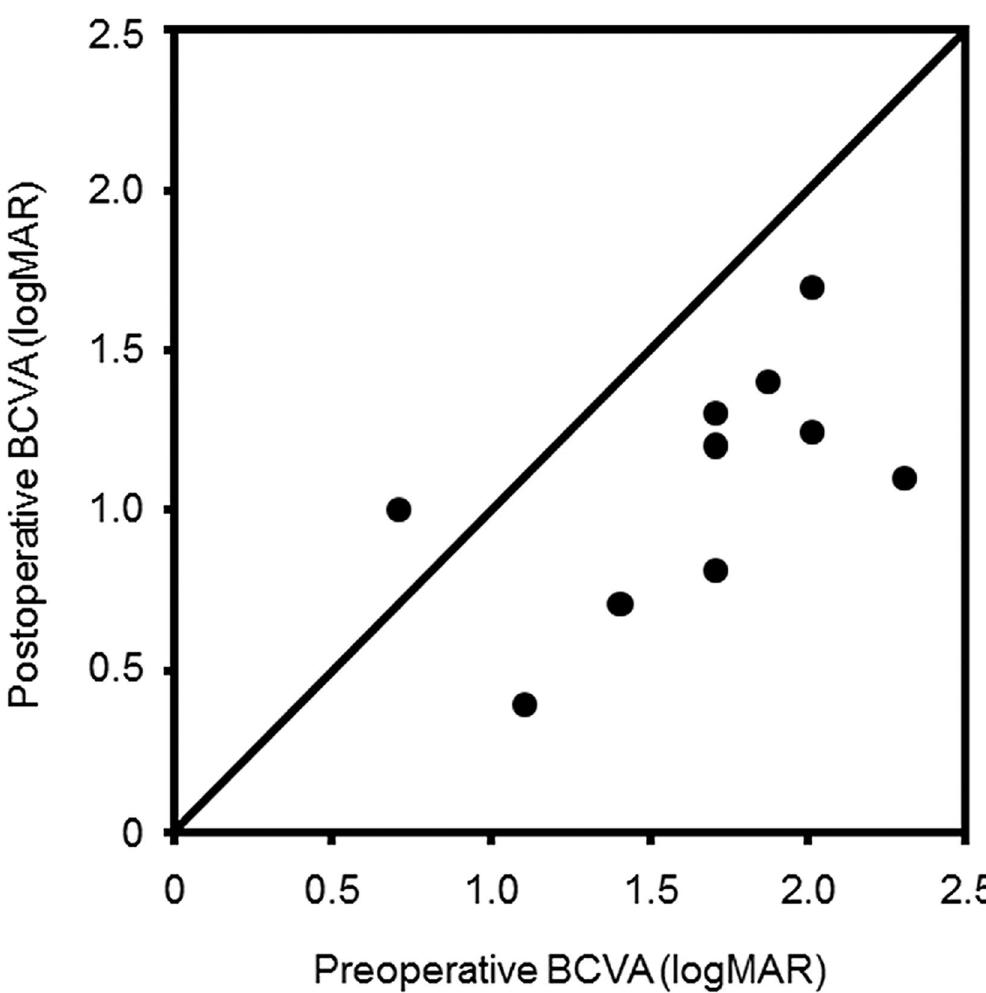
Fig 2. Changes in the preoperative and postoperative best-corrected visual acuities (BCVAs) of the eyes that underwent vitrectomyusing the inverted internal limiting membrane flap technique for macular holes with retinal detachments. The BCVAs were converted to the logarithm of the minimal angle of resolution (logMAR) units.